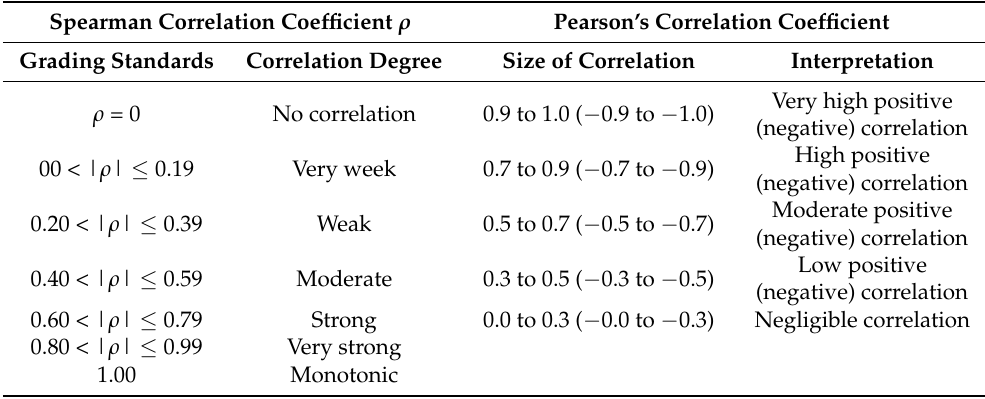
Table 1. Spearman and Pearson’s correlation coefficients and their degrees and interpretation. The table uses data from